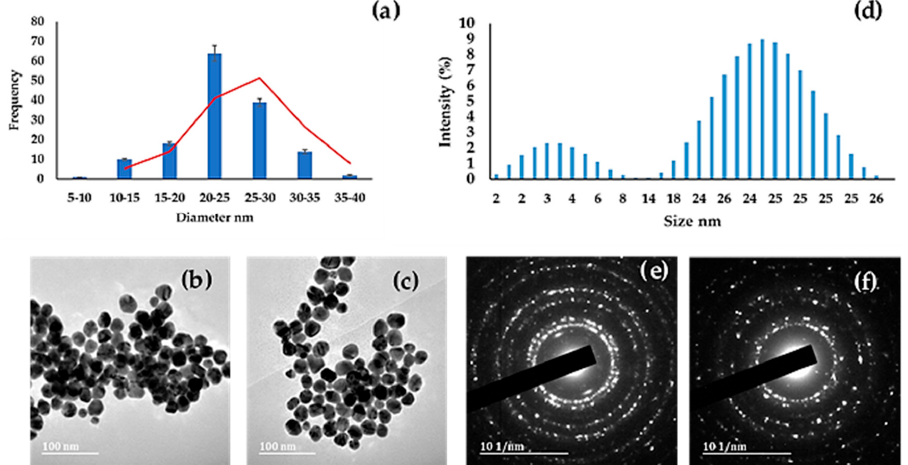
Figure 4. ( a ) Histogram obtained by measuring the diameter of AuNPs; ( b , c ) HRTEM images of tri ‐ sodium citrate AuNPs with the ( d ) zetasizer and ( e, f ) selected area of electron diffraction (SAED).